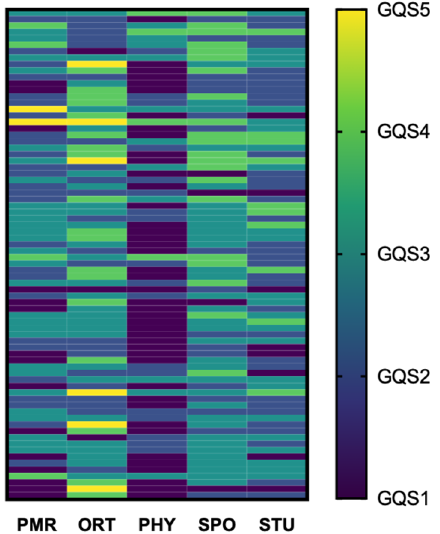
Figure 3. A heatmap of answers Global Quality Scale (GQS) assessments (1 = poor quality to 5 excellent quality) for each video (rows) and each rater (columns). Generally, GQS was low with a median of 2. A Kruskal–Wallis test with subsequent multiple comparisons showed significant differences between all rater’s mean ranks except for PMR vs. STU and ORT vs. SPO. Rater agreement as measured by Fleiss’ Kappa was poor (0.06).